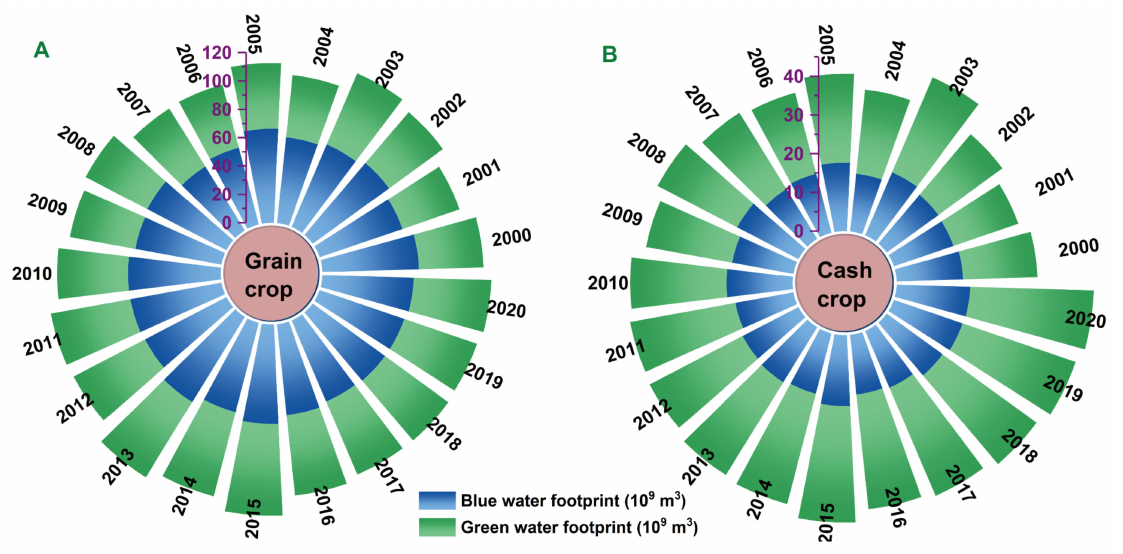
Figure 7. Composition of water footprint of grain and cash crops and its variation with